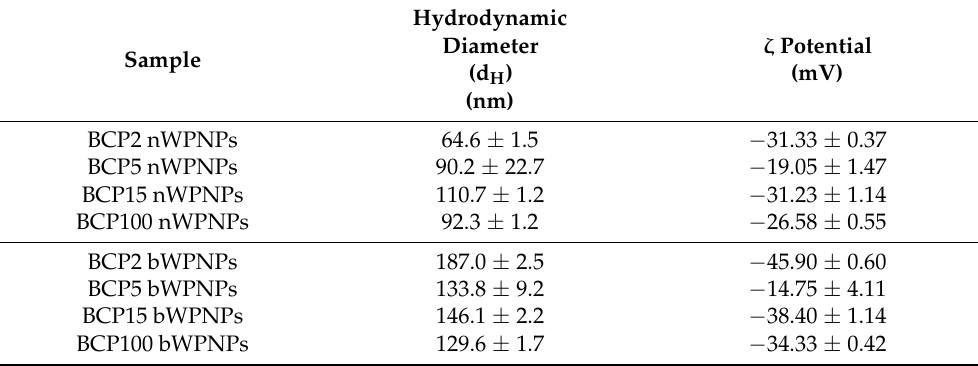
Table 1. Hydrodynamic diameters (d H ) expressed in the number and ζ potential of the nWPNP and bWPNP